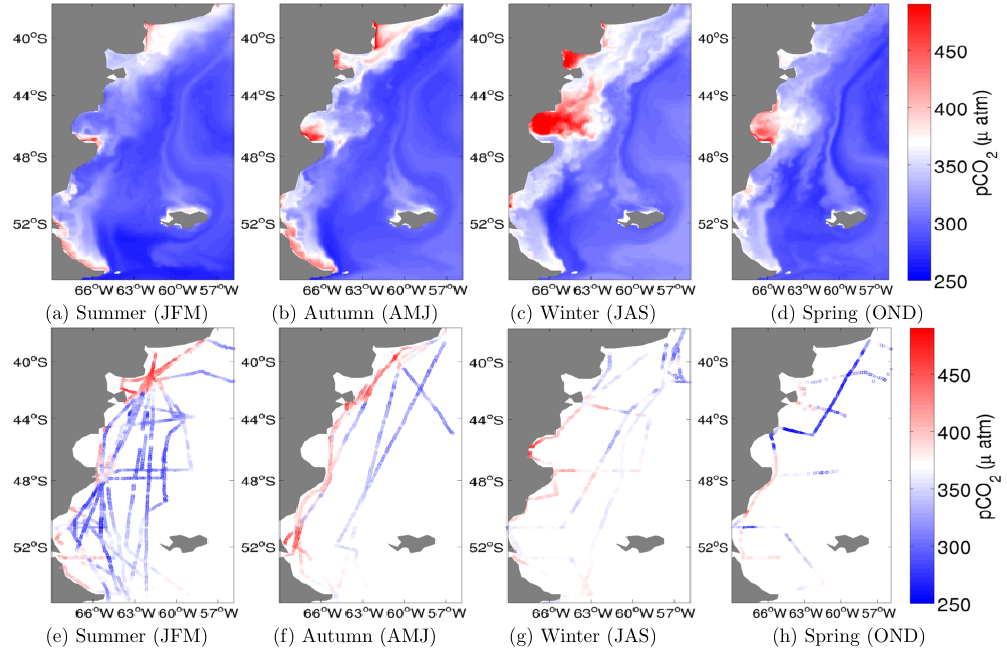
Figure 3. Model evaluation on the Patagonia Shelf (PS) (zoom in from model domain in Fig. 2a). Seasonal climatology of modeled ocean surface p CO 2 (upper row) and p CO 2 observations from ARGAU and GEF3 cruises(lower row) (Bianchi et al., 2009). The white separation between red and blue is set to 370µatm which is the atmospheric p CO 2 used in this study. Blue represents a sink of atmospheric CO 2 and red a